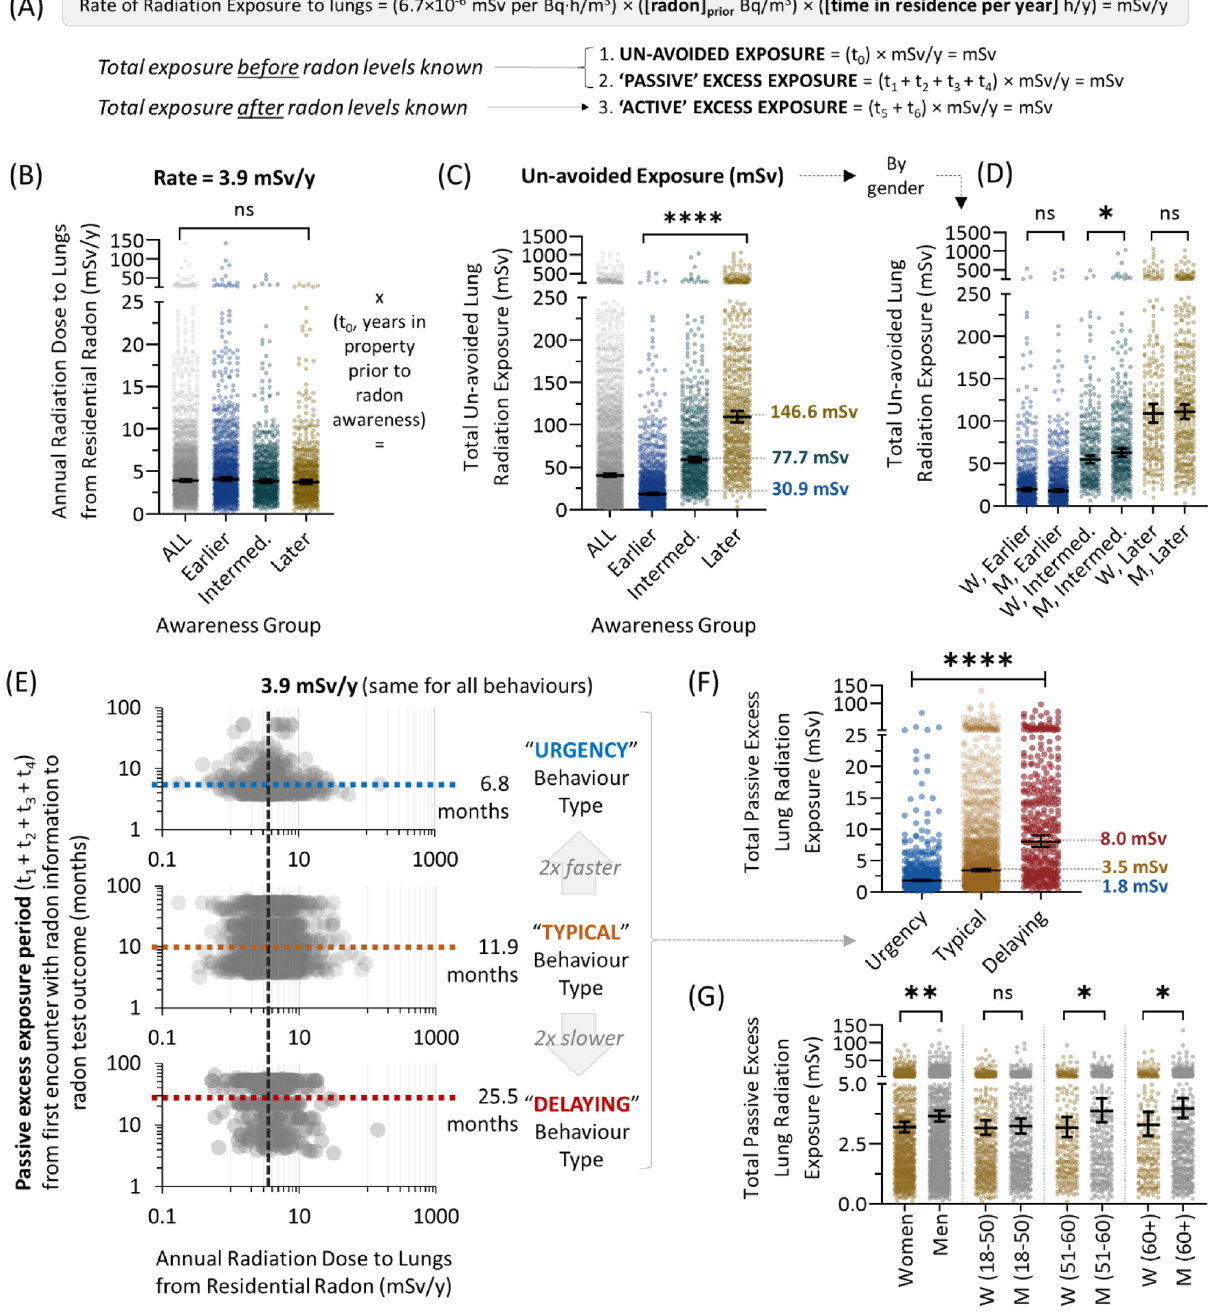
Figure 2. Variable doses of alpha particle radiation to the lungs as a function radon awareness and testing behaviour. ( A ) Conversion formulae and exposure group classifications. ( B ) Individual annual radiation doses to the lungs from residential radon for all participants, and as a function of initial awareness (t 0 ) groups. The geometric mean rate of ‘un-avoided’ exposure for all groups was 3.9 mSv/year. ( C ) Total radiation exposures incurred during t 0 for all participants and initial awareness groups. ( D ) Data from ( C ) separated by properties radon level, visualized by correlating the known radon level of their property with bracketed participant sex/ gender. ( E ) Passive exposure periods (t 1+2+3+4 ) for groups defined by radon test behaviour types. ( F ) Total radiation exposures incurred during (t 1+2+3+4 ) as a function of radon test behaviour types. Data from ( F ) separated by participant age group and sex/gender. Statistical comparisons are Mann–Whitney pairwise nonparametric t-tests of comparisons for scatter plot data. ****p < 0.0001; ***p < 0.001; ns = p > 0.05. Figures were prepared using Excel and GraphPad Prism 9.1.1 (225) (www. graph pad.